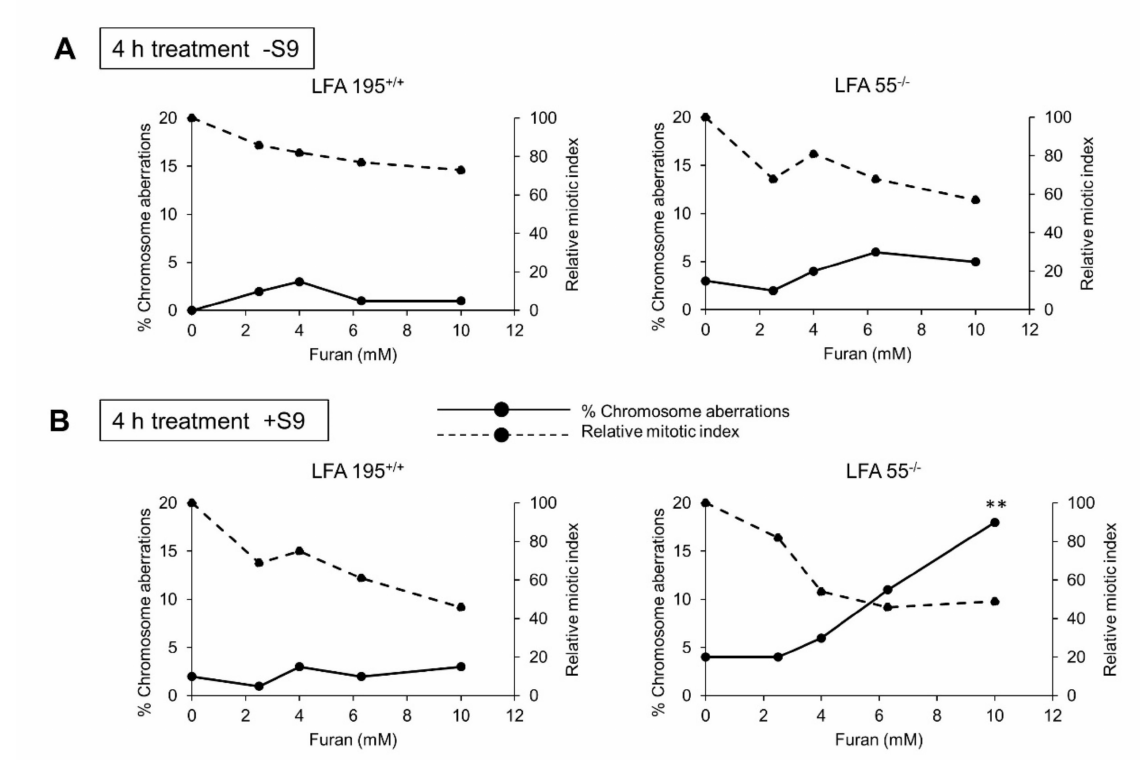
Figure 4. Chromosomal aberrations induced by 4 h exposure to furan in immortalized lymphoblastoid cell lines originated from a “normal” individual (LFA195 +/+ ) or a patient with FA (LFA55 − / − ). ( A ) Treatments performed in the absence of S9 metabolic activation. ( B ) Treatments performed in the presence of S9 metabolic activation. Rat livers S9 tissue homogenates, prepared from animals induced with isoniazid to accumulate high levels of cytochrome P450 2-E1. ** p <